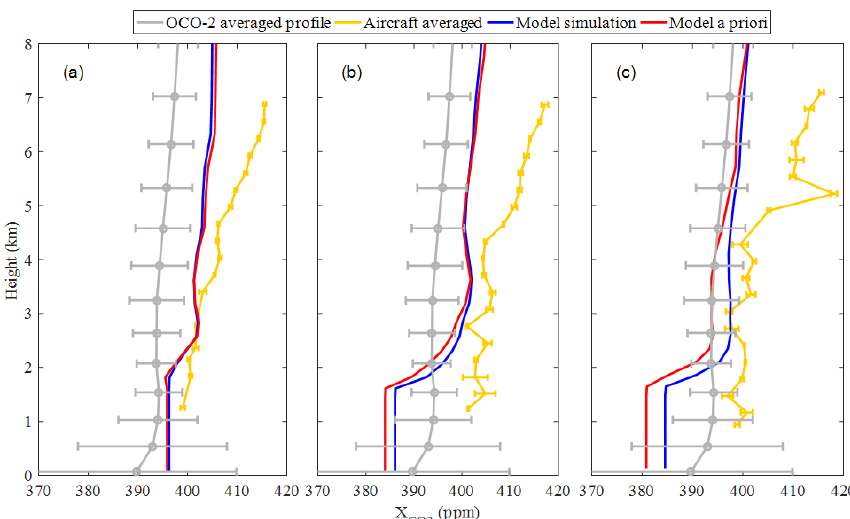
Figure 6. Comparison of aircraft measurements (in situ measurement data are shown by the yellow line) with 1 standard deviation (yellow bars) collected on (a) 7, (b) 9 and (c) 10 August Tan-Tracker (v1) data (blue line) and the a priori profile of it (red line) at the location of Jiansanjiang linearly interpolated to the observation times on (a) 7, (b) 9 and (c) 10 August and the OCO-2 averaged profile (gray line) for the aircraft flight area from 5 August with 1 standard deviation (gray